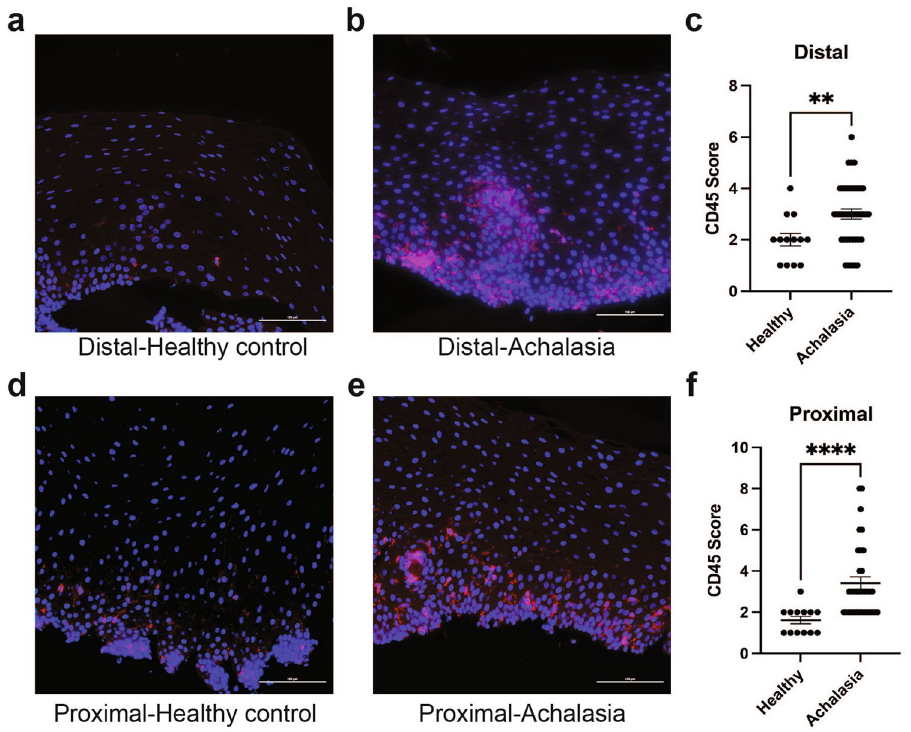
Figure 6. Increase infiltration of intraepithelial leukocyte in achalasia. ( a , b , d , e ) Representative immunofluorescence for the leukocyte marker CD45 (red) in the esophageal mucosa of achalasia subjects ( b , e ) compared to healthy control ( a , d ). Results from distal esophagus are shown in ( a , b ) as well as results from proximal esophagus are shown in ( d , e ). Dapi (blue) was used as a nuclear stain. Scale bars: 100 μm. ( c , f ) Column graph with individual values showing scoring for CD45+ intraepithelial leukocytes in distal ( c ) and proximal ( f ) esophageal mucosa of achalasia subjects compared to healthy controls. **P < 0.005, ****P < 0.0001. n = 12 healthy controls and 38